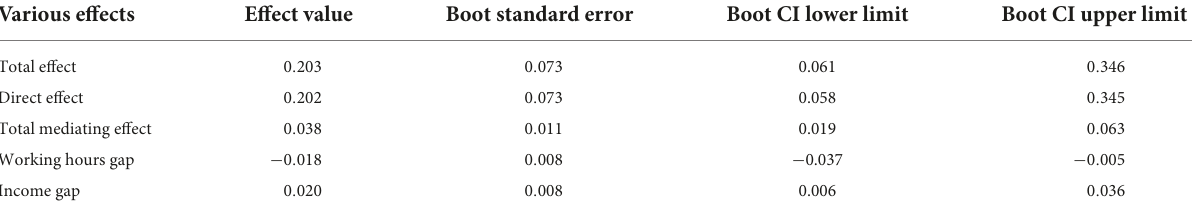
TABLE 7 Parallel mediation